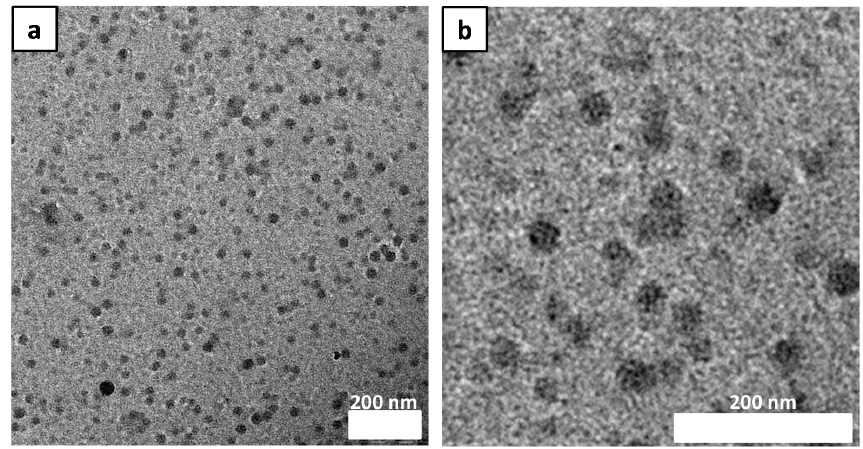
Figure 1. ( a ) TEM image of PS 10K -PNaSS 10K -PS 10K diluted in DMF/water, stained and dried under ambient conditions ( b ) Enlarged image of ( a ).